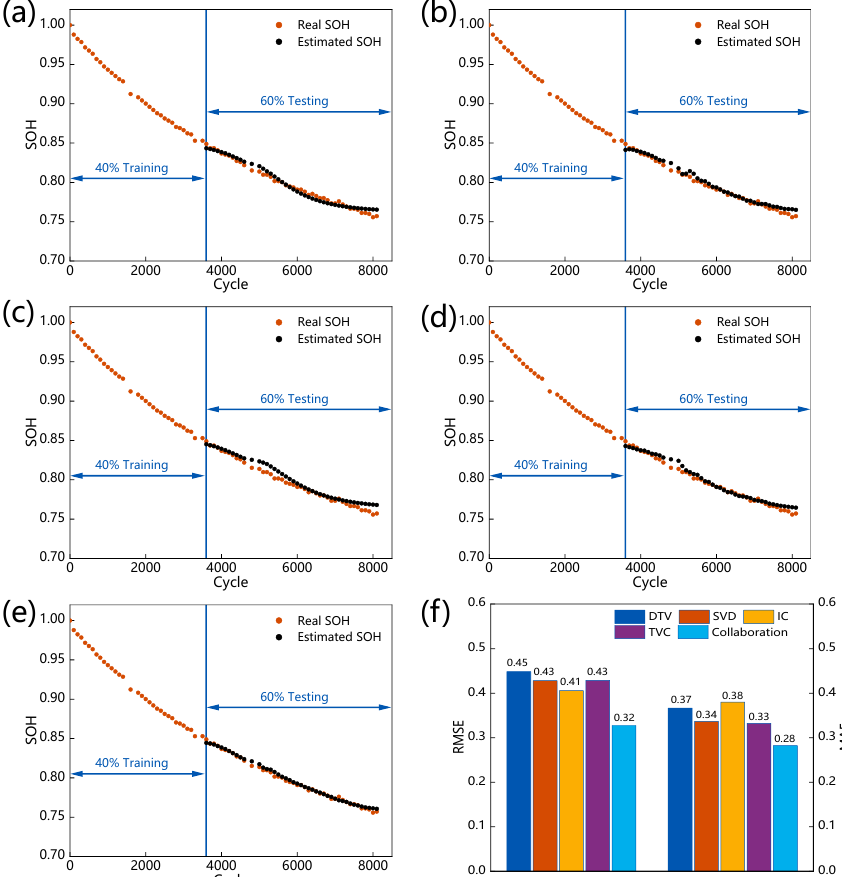
Figure 7. Results on Oxford cell1 based on different methods: ( a ) DTV. ( b ) SVD. ( c ) IC. ( d ) TVC. ( e ) Multi-feature collaboration. ( f ) MAE and RMSE analyses.